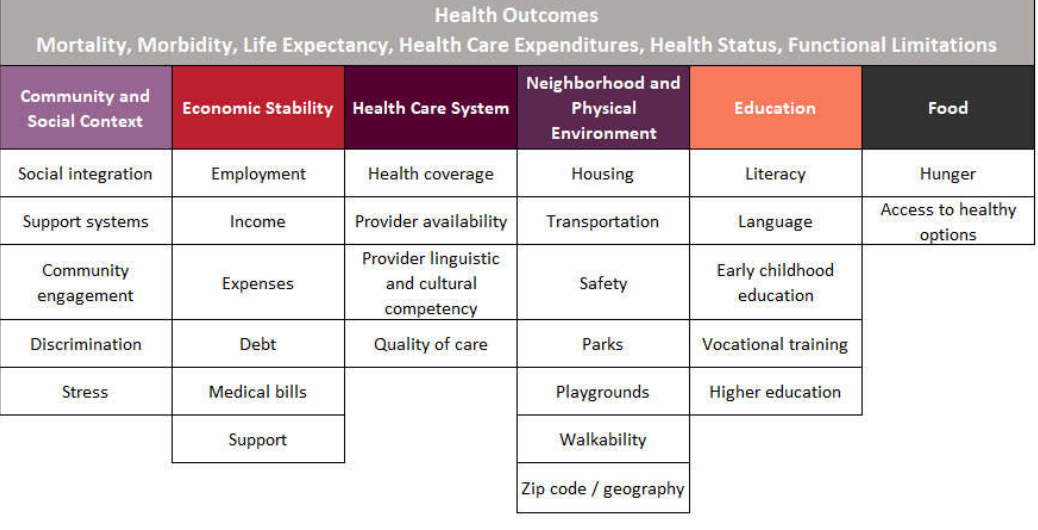
Figure 2. Social drivers of health framework adapted from Kaiser Family Foundation (KFF).